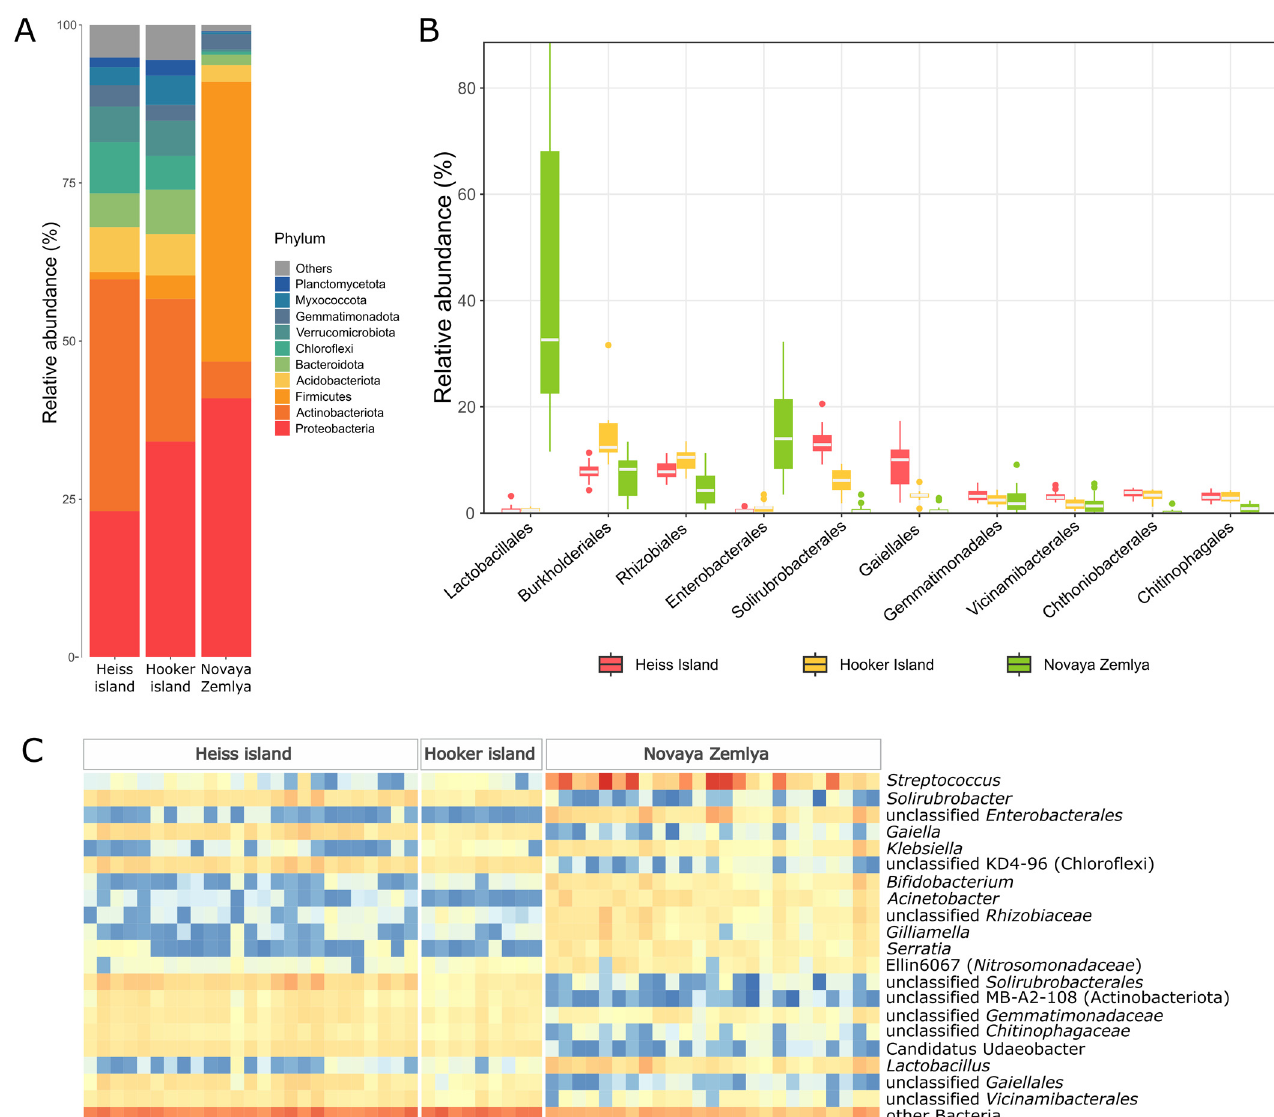
Figure 4. Microbial abundance in the soil samples: ( A )—The proportion of the bacterial phyla in the soils, ( B )—Boxplot of the top 10 order abundances in each sample, ( C )—Abundance heatmap of the genera, comprising more than 5% at least in one of the samples.